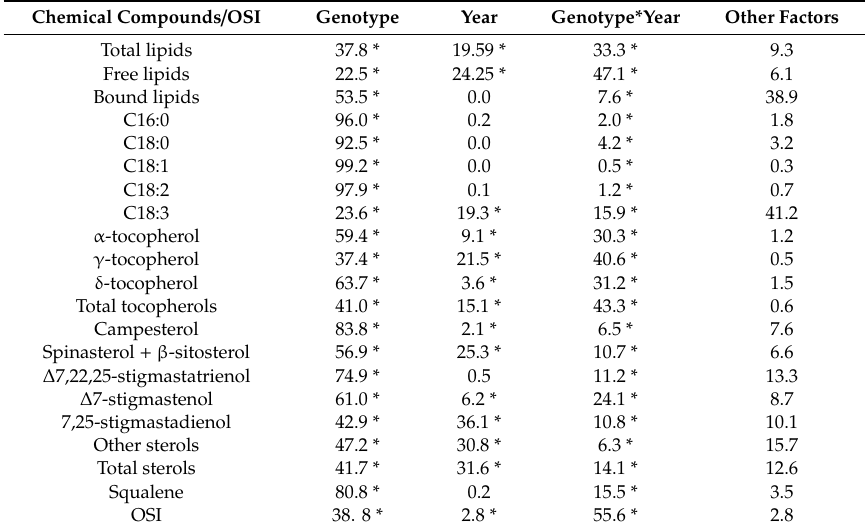
Table 2. E ff ect of year and Styrian oil pumpkin genotype (% of explained variance) on analyzed chemical compounds of seed lipids and oxidative stability index